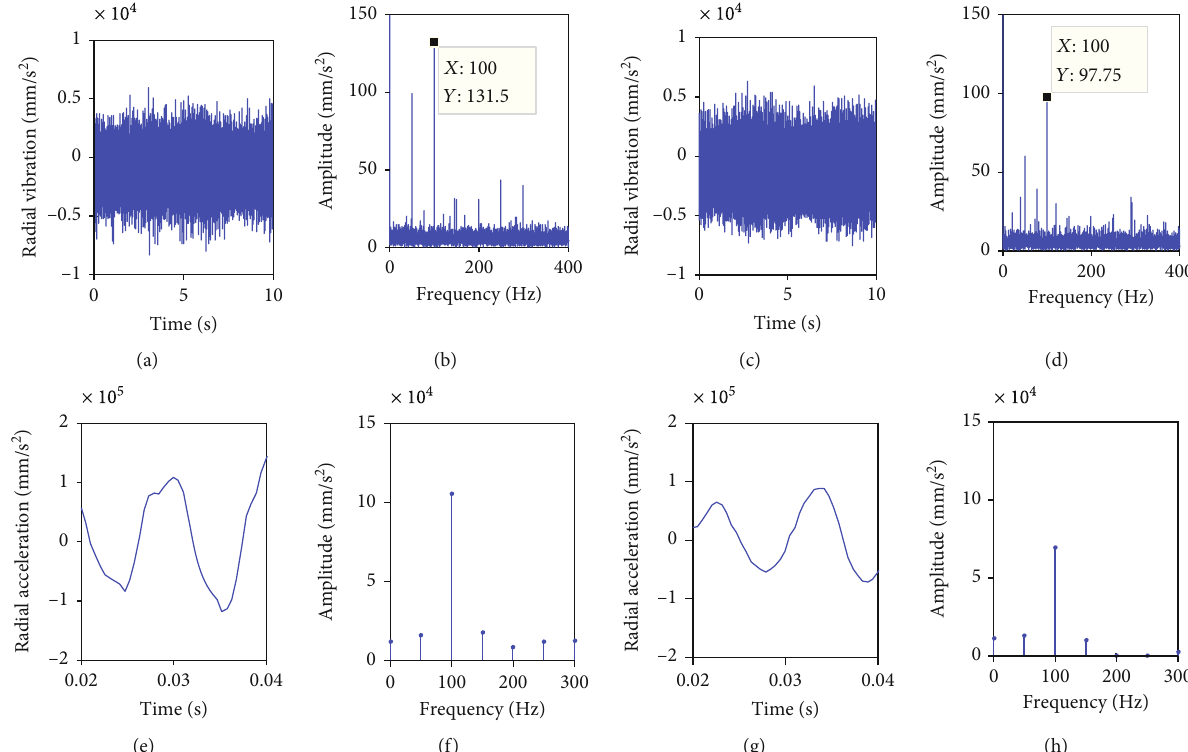
Figure 11: Time-domain waves and spectra of radial accelerations: (a, b) sensor A in experiment, (c, d) sensor B in experiment, (e, f) probe A in simulation, and (g, h) probe B in simulation.